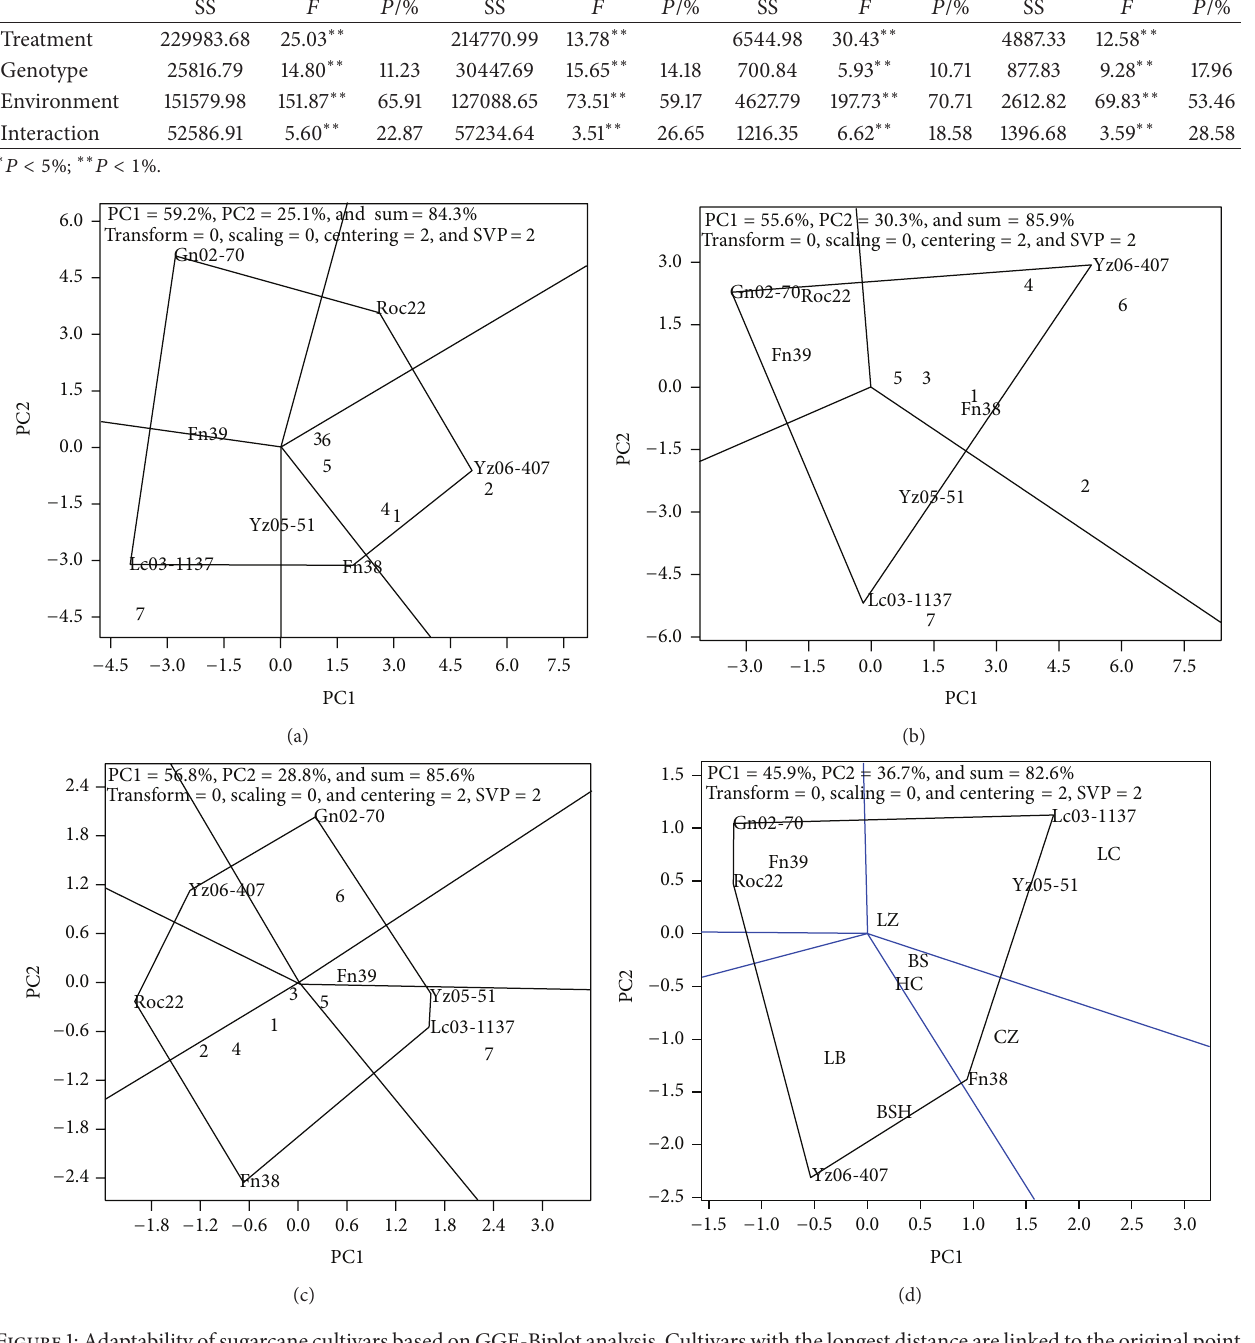
Figure 1: Adaptability of sugarcane cultivars based on GGE-Biplot analysis. Cultivars with the longest distance are linked to the original point to form a multilateral figure and vertical lines are drawn to each side of the figure to divide the whole biplot into several fan-shaped regions and to assort evaluation sites into different groups. Within each group, the cultivars located at the apex of the multilateral figure represent the best ones among the cultivars within the fan-shaped region: (a) 2011 plant crop cane yield; (b) 2012 ratoon crop cane yield; (c) 2011 plant crop sugar yield; and (d) 2012 ratoon crop sugar yield. PC1 = principal component 1; PC2 = principal component 2. Numerical codes for evaluation Sites: 1 = Guangxi Baise; 2 = Guangxi Chongzuo; 3 = Guangxi Hechi; 4 = Guangxi Laibin; 5 = Guangxi Liuzhou; 6 = Yunnan Baoshan; and 7 = Yunnan Lincang. Codes for cultivars: Fn39 = Funong 39; Fn38 = Funong 38; Yz06-407 = Yunzhe 06-407; Yz05-51 = Yunzhe 05-51; Lc03-1137